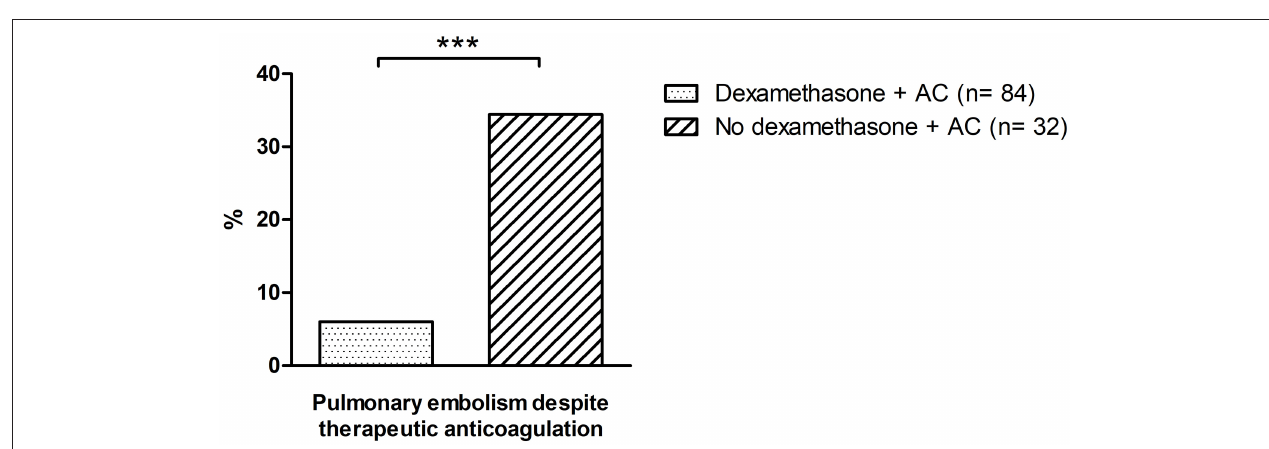
FIGURE 3 | Incidence of pulmonary embolism despite therapeutic anticoagulation in patients treated with dexamethasone vs. controls. *indicates a p of < 0.05; ** a p of < 0.01 and *** a p of < 0.001, n.s., not significant. AC, anticoagulation.